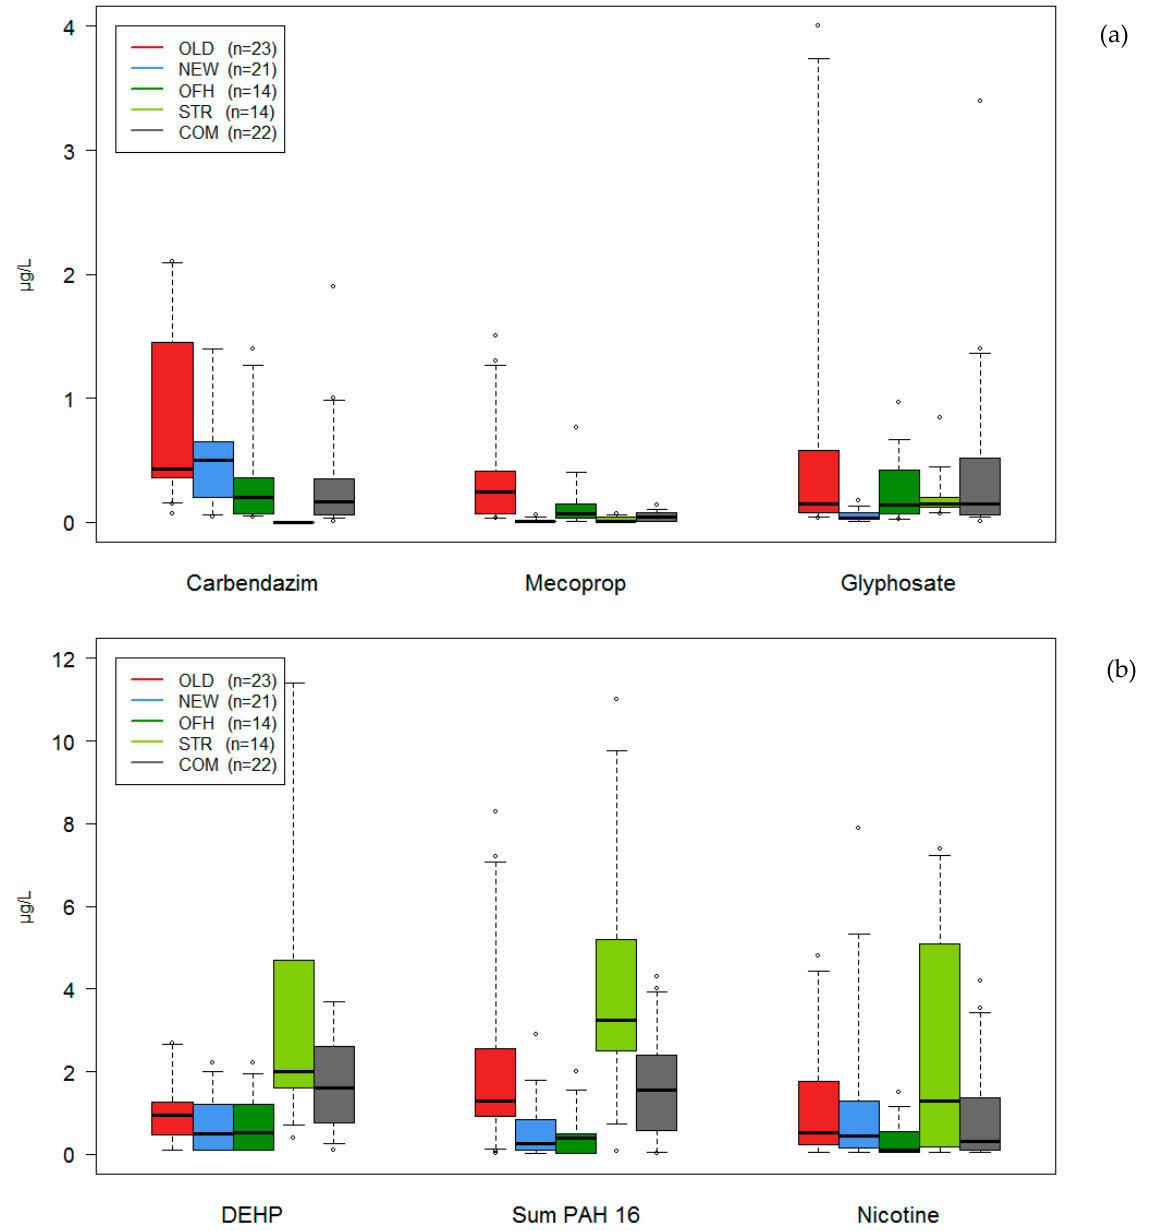
Figure 4. Concentration boxplots of selected biocides/pesticides ( a ) and DEHP, PAH and nicotine ( b ) by catchment type (OLD—old building areas, NEW—high-rise newer buildings, OFH—one-family houses, STR—streets >7500 vehicles/d, COM—commercial areas). Whiskers show 5%/95% quantiles.